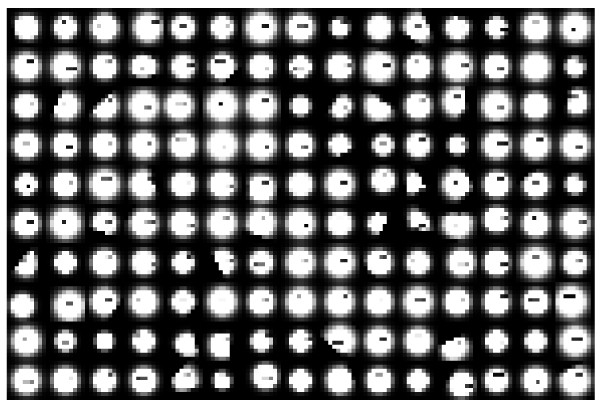
Slide generation errors. Errors in slide image generation are demonstrated. There is large variation in the spot size. In addition many spots have unideal shapes.